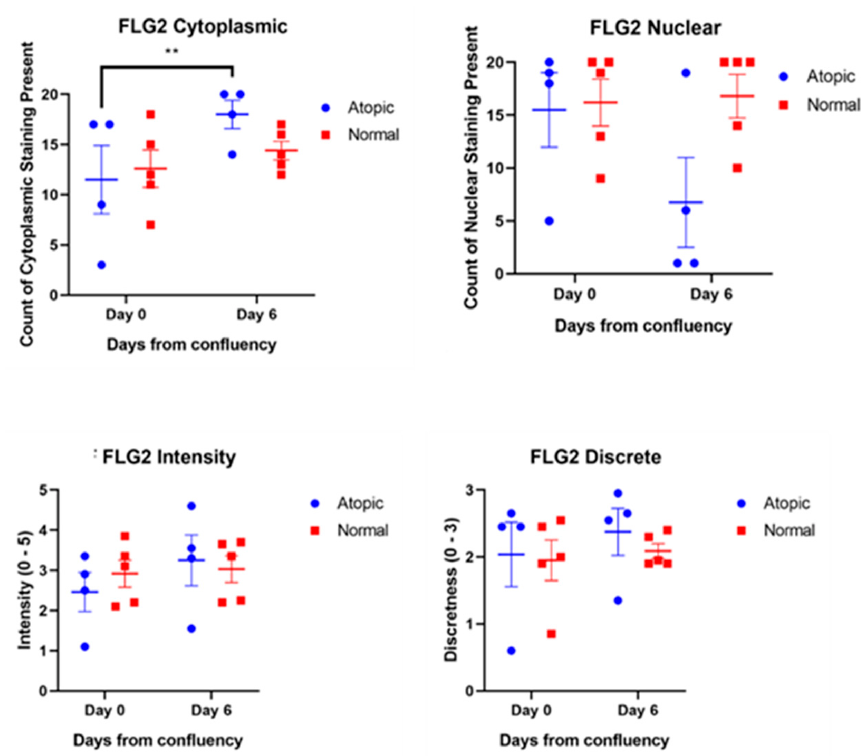
Figure 6. Filaggrin 2 staining was scored for location, intensity, and discreteness by four observers unaware of the source of the cells. The increase of cytoplasmic filaggrin-2 on D6 was significant in atopics ( p = 0.0067). The decrease of staining of filaggrin-2 in the nucleus at D6 approached significance in the atopics ( p = 0.055). For this scoring four atopic cell cultures and five normal cell cultures were used. ** is for p < 0.005.